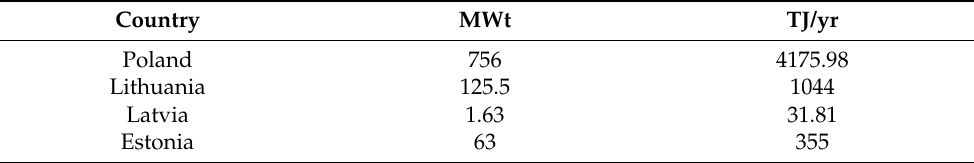
Table 2. Comparison of installed capacity in Poland, Lithuania, Latvia and Estonia for the direct application of geothermal energy (based on available data for 2020)